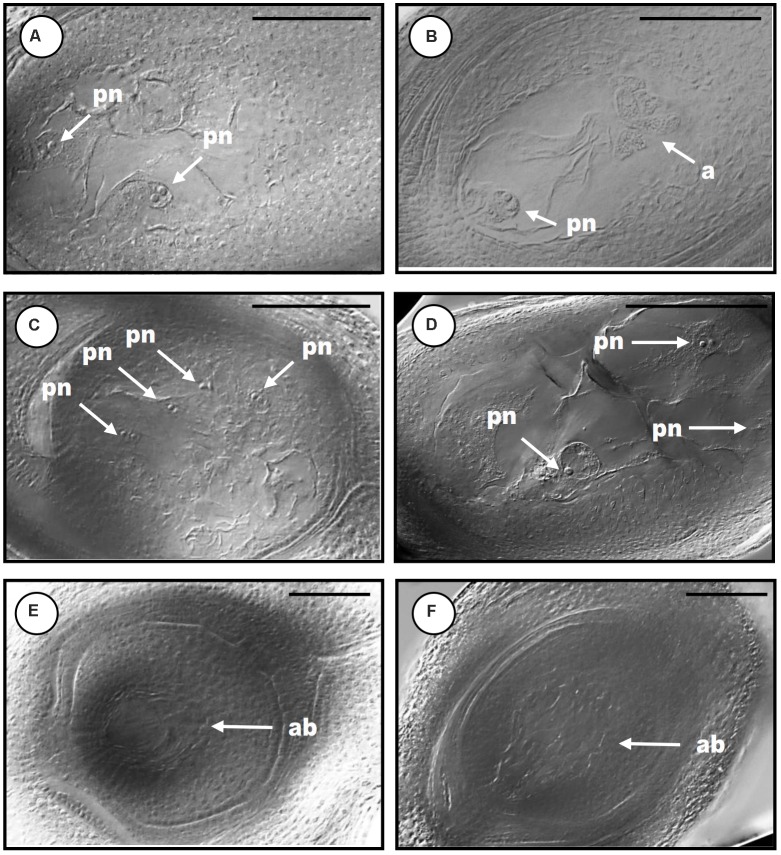
Cytoembryological analysis of the reproductive behavior in QGJ RNAi lines. Mature ovules of wild type genotype Q4117 (A,B), transformation control lines #TC1 (C) and #TC2 (D) and QGJ RNAi lines #RNAi1 (E) and #RNAi2 (F). Aposporous embryo sacs (A,C,D). Meiotic embryo sac (with a proliferating mass of antipodals) (B). Aborted embryo sacs (E,F). References: pn, polar nuclei; a, antipodals; ab, aborted. Bars: 100 μm.